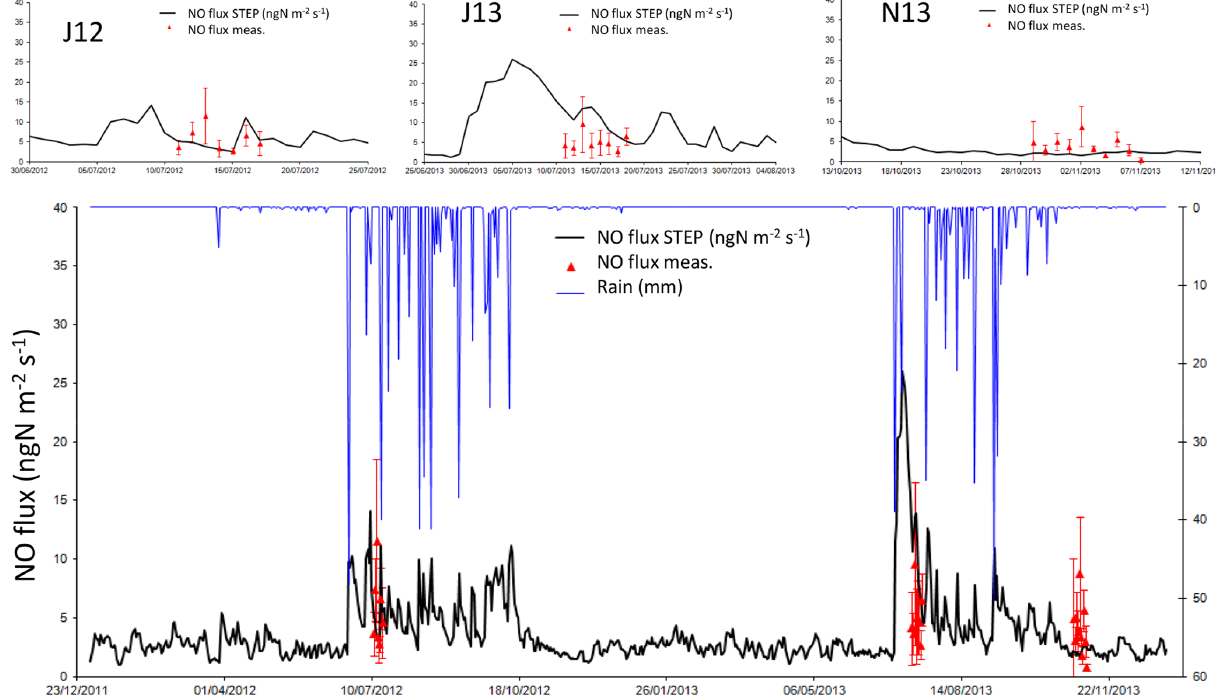
Figure 5. Daily NO flux simulated by STEP–GENDEC–NOFlux (ngNm − 2 s − 1 , black line) and daily averaged NO flux measurements during the three field campaigns (red triangles). Error bars in red give the standard deviation for measurements at the daily scale. Rain is represented by the blue line in millimetres in the bottom panel. The upper panels show a focus on each field campaign.